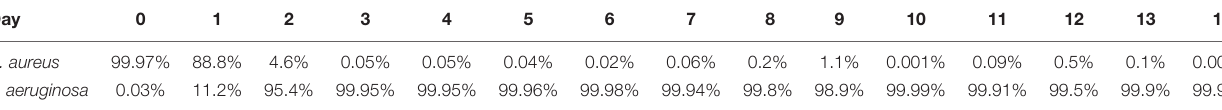
TABLE 3 | Ratio of S. aureus and P. aeruginosa when co-cultured in dual-species biofilms on tube reactors at 22 ◦ C. Day 0 S. aureus 99.97% 88.8%